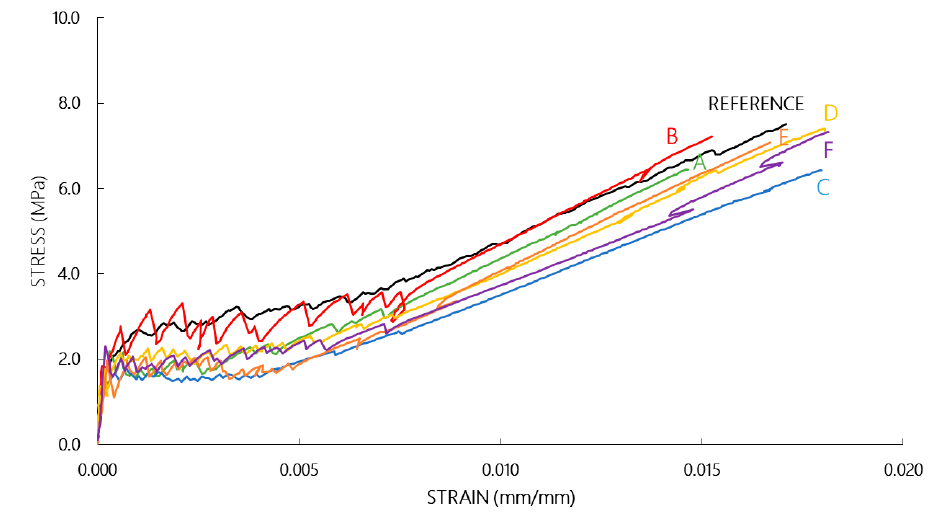
Figure 10. Residual behavior of TRC CYCL. 0.5 MPa.